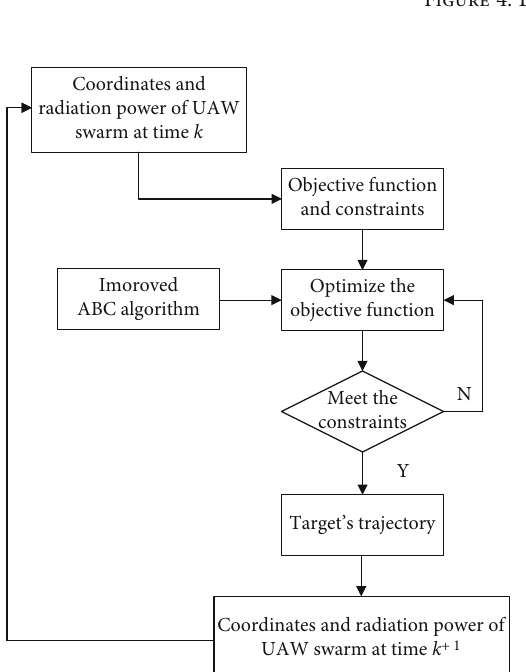
Figure 5: Detection resource optimization process based on the improved ABC